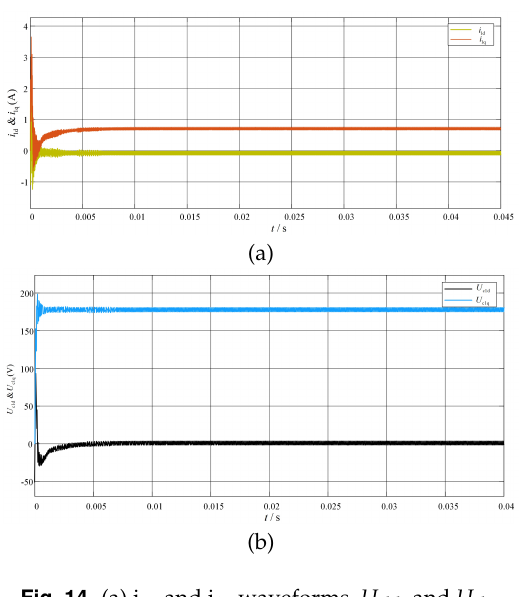
Fig. 14. (a) i 1 d and i 1 q waveforms, U cld and U clq